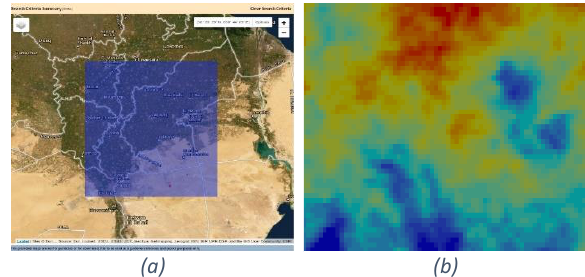
Figure 6 .(a) The total footprint of DEM available online and (b) DEM clipped to fit the study area.